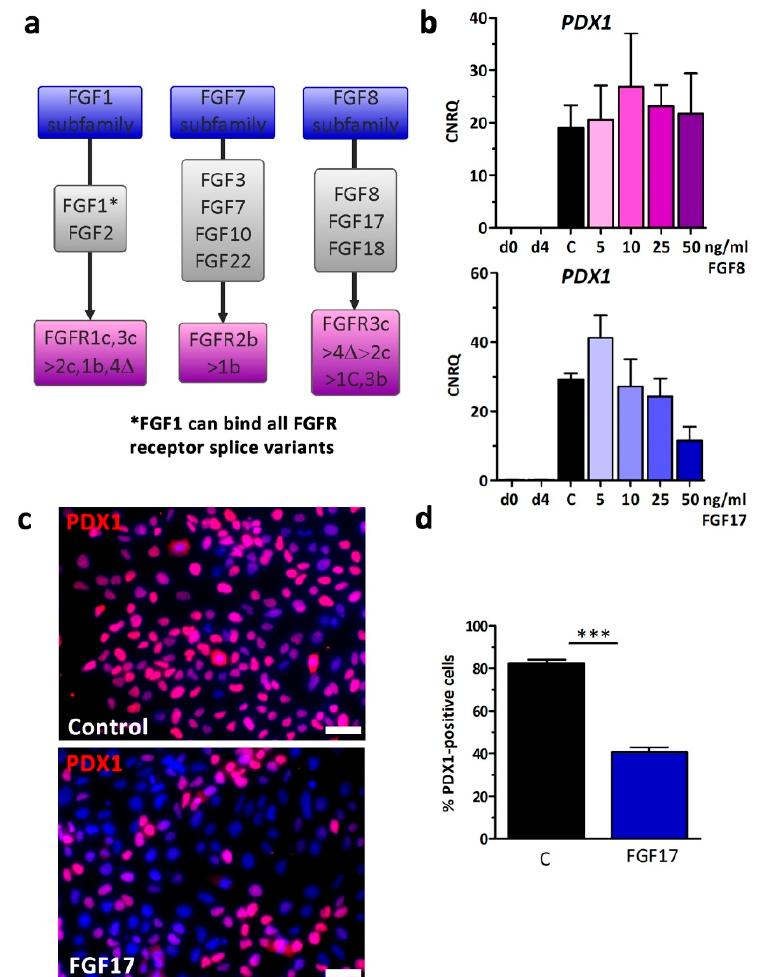
Figure 5. FGF-signaling through FGFR1c/3c inhibits pancreatic development. ( a ) Schematic presentation of ligand and receptor specificities of selected FGF family members [24,25]. ( b ) hESCs were subjected to 5–50 ng/mL FGF8 or FGF17 during differentiation into PDX1-positive cells compared to control without growth factors. The gene expression change of PDX1 is presented as means ± SEM, n = 3–4. ( c ) Representative fluorescence micrographs after pancreatic differentiation illustrating the protein expression of PDX1 after a 4-day treatment ± 50 ng/mL FGF17. Nuclei were counterstained with DAPI. Scale bar = 50 µm. ( d ) Quantification of PDX1-positive cells at d8. Data are means ± SEM, n = 3. *** = p ≤ 0.001, two-tailed Student’s t -test.